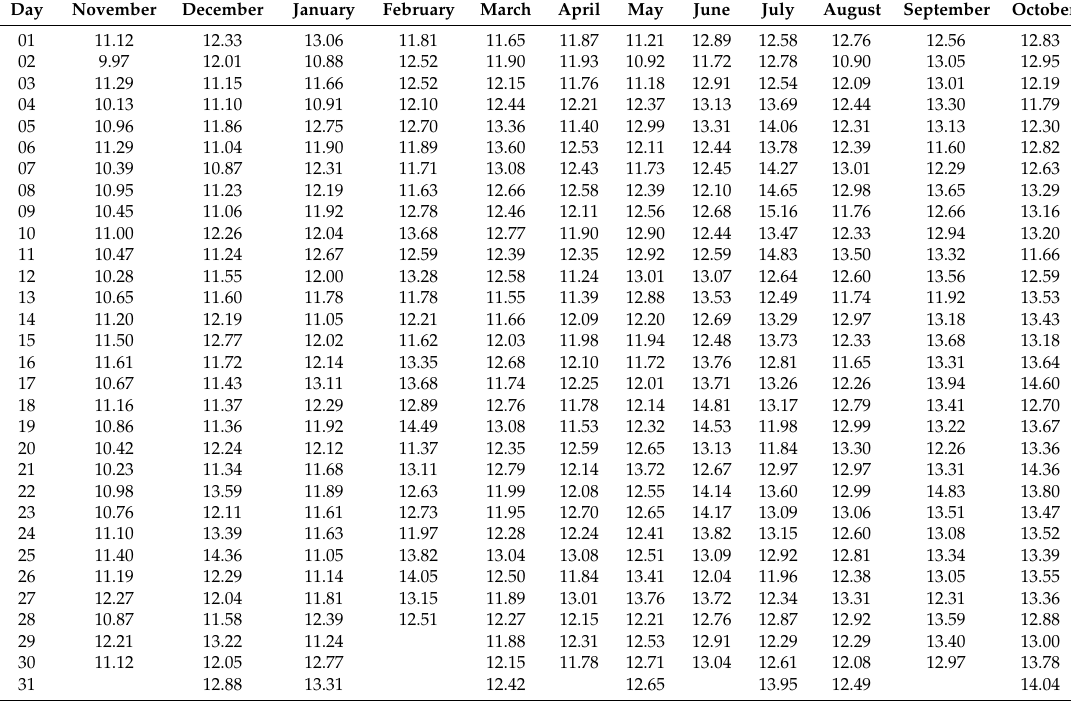
Table A4. Daily electrical demand in kWh for Kitonyoni mini-grid, November 2013-October 2014 (part of the source data for Figure